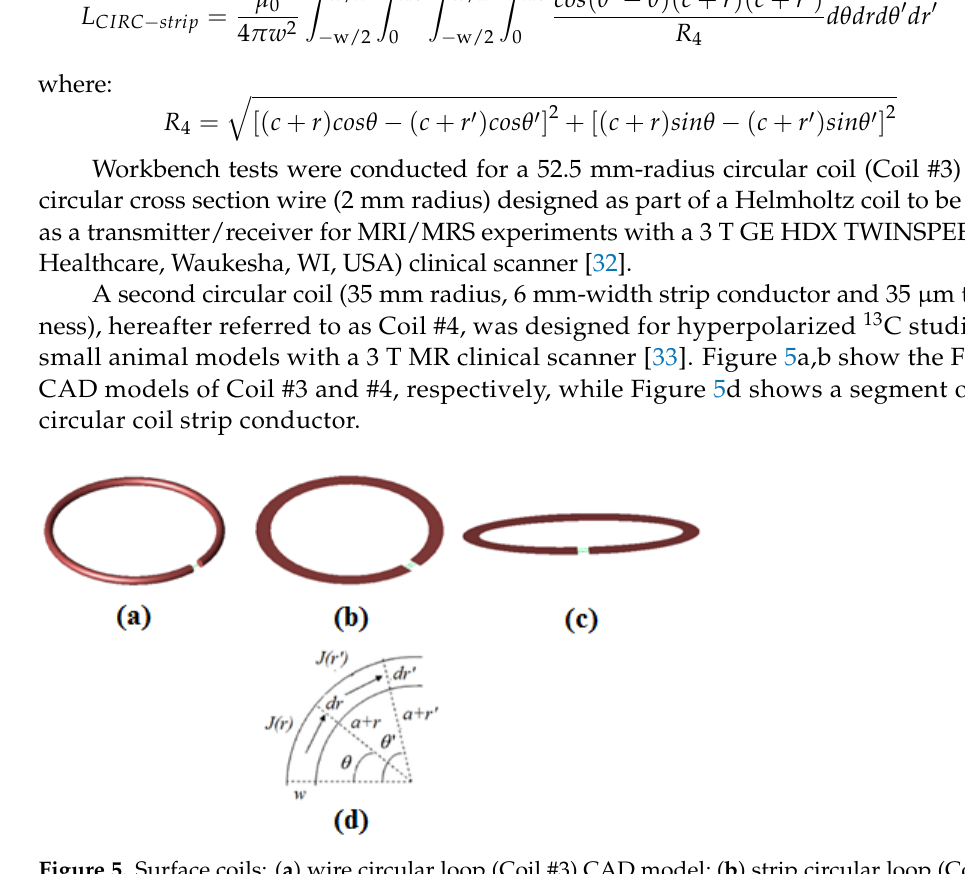
Figure 5. Surface coils: ( a ) wire circular loop (Coil #3) CAD model; ( b ) strip circular loop (Coil #4) CAD model; ( c ) elliptical loop (Coil #5) CAD model; ( d ) circular coil strip conductor segment.